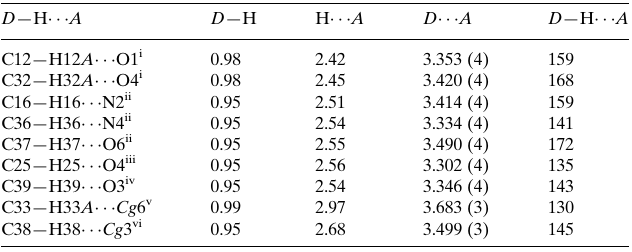
Hydrogen-bond geometry (A˚ , (cid:2) ). Cg 3 and Cg 6 are the centroids of the C15–C20 and C35–C40 rings,